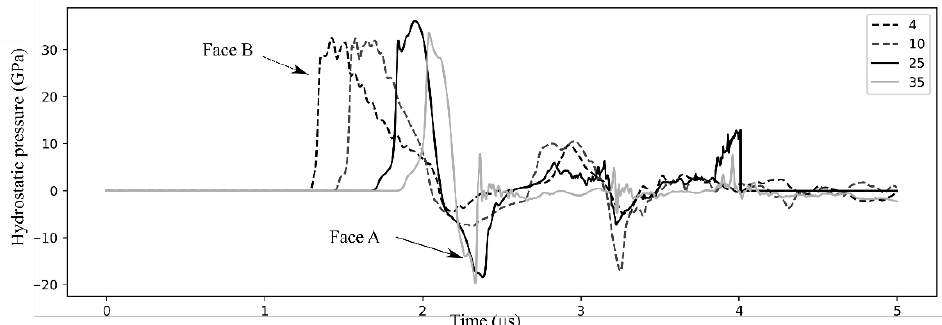
Fig. 6 Simulated hydrostatic pressure history graph of Face A (solid) and Face B (dotted). Positive pressure indicates